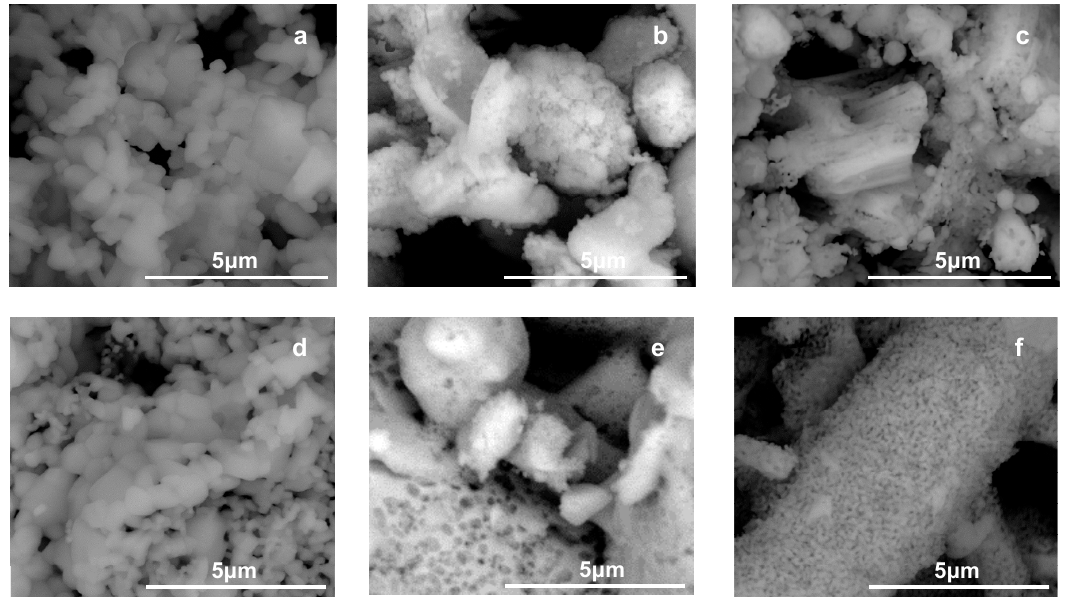
Figure 3. Field Emission Scanning Electron Microscope (FESEM) images of: ( a ) Ti-0.1-1000, ( b ) Zr-1.0-1000, ( c ) Ti,Zr-0.6-1000, ( d ) Ti-1.2-1000, ( e ) Zr-1.5-1000, ( f ) Ti, Zr-1.2-1000.